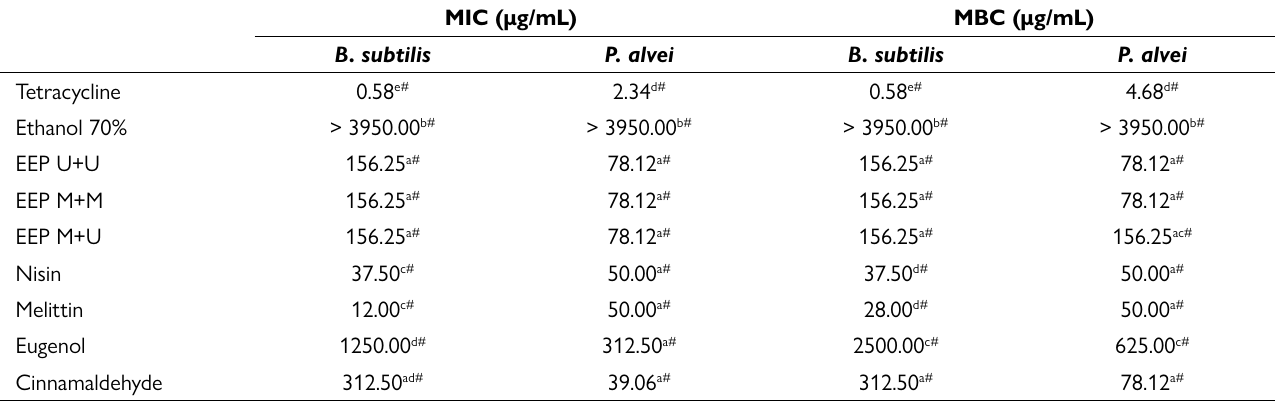
Table 2. Minimum inhibitory concentration (MIC) and minimum bactericidal concentration (MBC) (µg/mL) using the microdilution methodology (REMA) against P. alvei and B. subtilis .